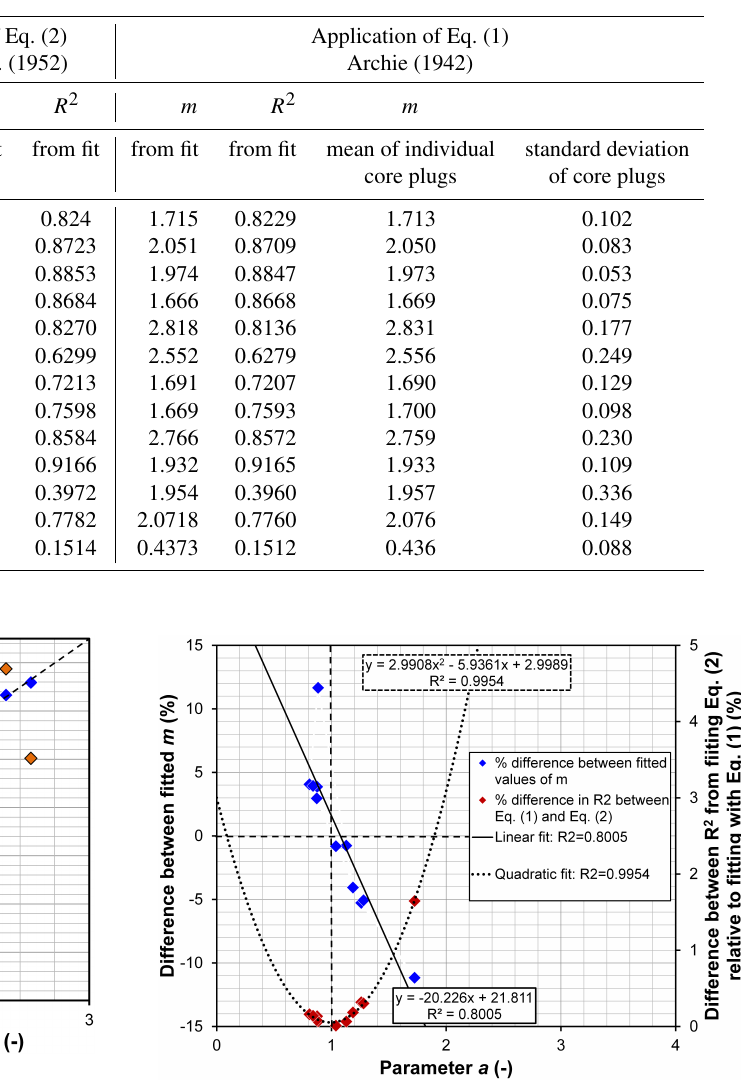
Figure 3. Percentage difference between cementation exponents derived from Eq. (2) with respect to that derived from the use of Eq. (1) (i.e. (cid:0)(cid:0) m Eq. 2 − m Eq. 1 (cid:1) /m Eq. 1 (cid:1) × 100) as a function of the a parameter (blue symbols), with a linear least-squares regression ( R 2 = 0.8005), together with the percentage differ- ence between the adjusted R 2 fitting coefficients for fitting with Eq. (2) with respect to that derived from the use of Eq. (1) (cid:16)(cid:16) (cid:17) (cid:17) × 100 ) as a function of the a pa- − R 2 /R 2 R 2 (i.e. Eq. 1 Eq. 2 Eq. 1 rameter (red symbols), with a quadratic least-squares regression ( R 2 = 0.9954).